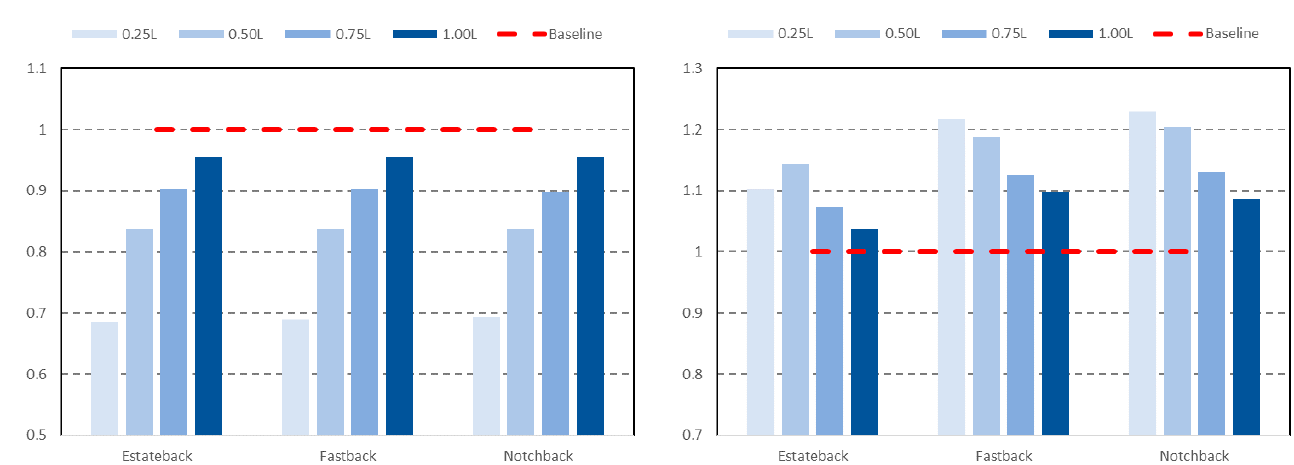
Figure 7. Drag ratios results of a leading NB ( left ) and a trailing NB ( right ) in different inter-vehicle spacing and configura- tion order normalised against the baseline results of an NB.